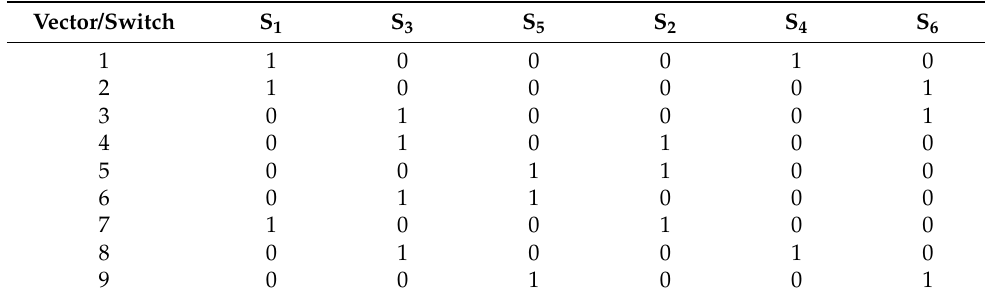
Table 2. Definition of the rectifier